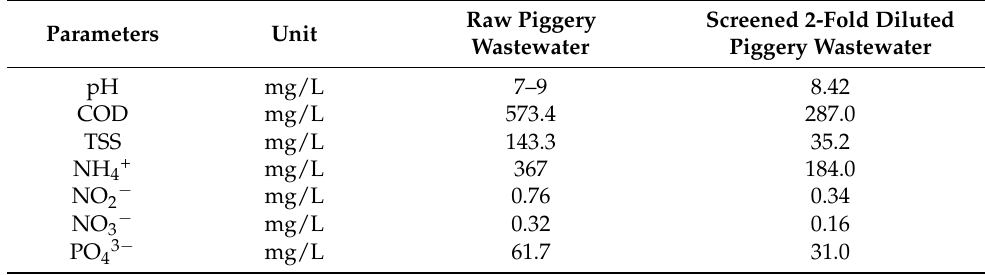
Table 1. Characteristics of the raw and 2-fold diluted piggery wastewater used in this study.